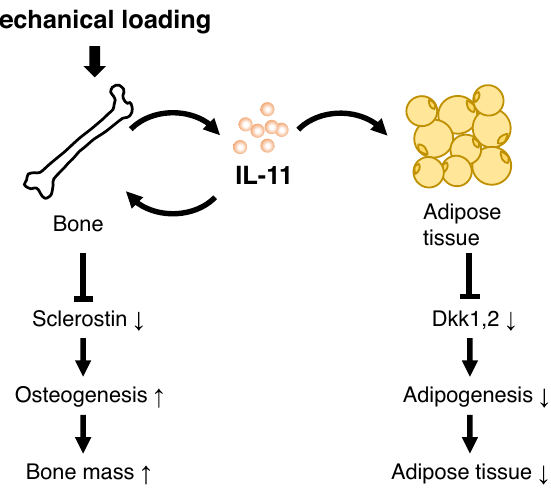
Fig. 8 | Diagram of the summary of the present observations in the regulation ofboneandadiposetissuemassbyexercise-inducedmechanicalloadingtothe bone. Exercise creates mechanical loading to the bone, which stimulates IL-11 expression in the bone. IL-11 produced in the bone acts locally to enhance osteo- genesis via a stimulation of Wnt signaling by suppressing the expression of Wnt inhibitorsincludingsclerostin,andincreasesbonemass.Atthesametime,exercise- induced increase in IL-11 in the bone acts like a hormone, and suppresses the expression of Wnt inhibitors, Dkk1 and 2, in the adipose tissue. The enhanced Wnt signaling in the adipose tissue suppresses adipogenesis to increase energy supply for